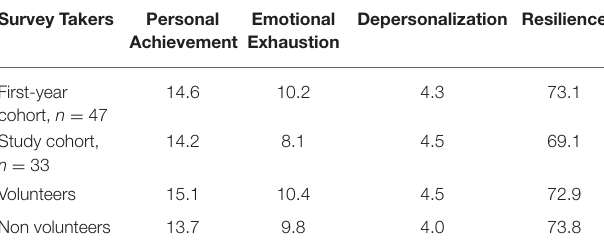
TABLE 2 | Comparison of means of burnout and resilience measures across survey takers from the first-year cohort, current study cohort, volunteers and non-volunteers from the current study cohort showed no significant